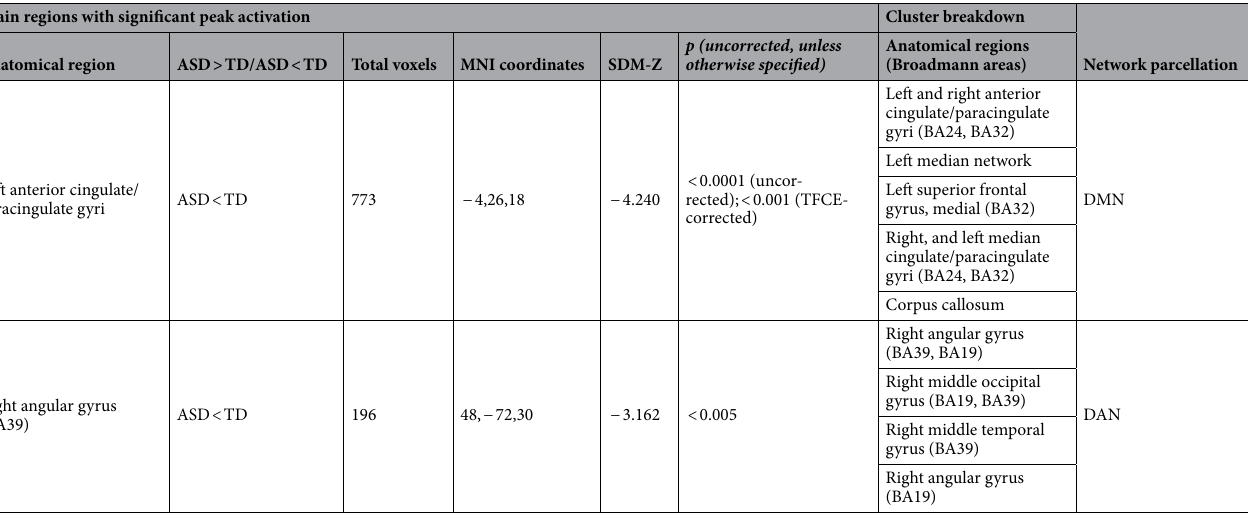
Table 3. fMRI meta-analysis on EC components (inhibitory control) with age as a